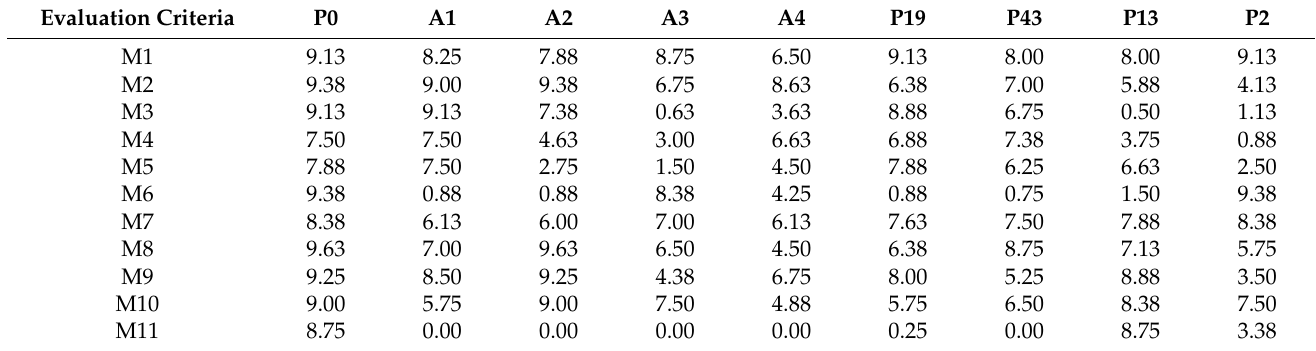
Table 10. Information table about the eight comparative sequences and the reference sequence.